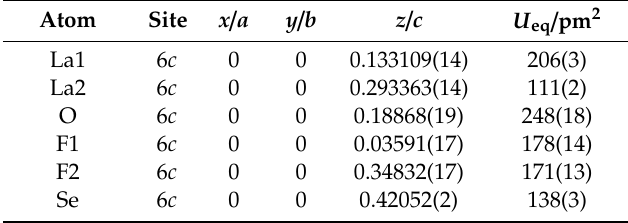
Table 2. Fractional atomic coordinates and U eq values a for A-La 2 OF 2 Se.